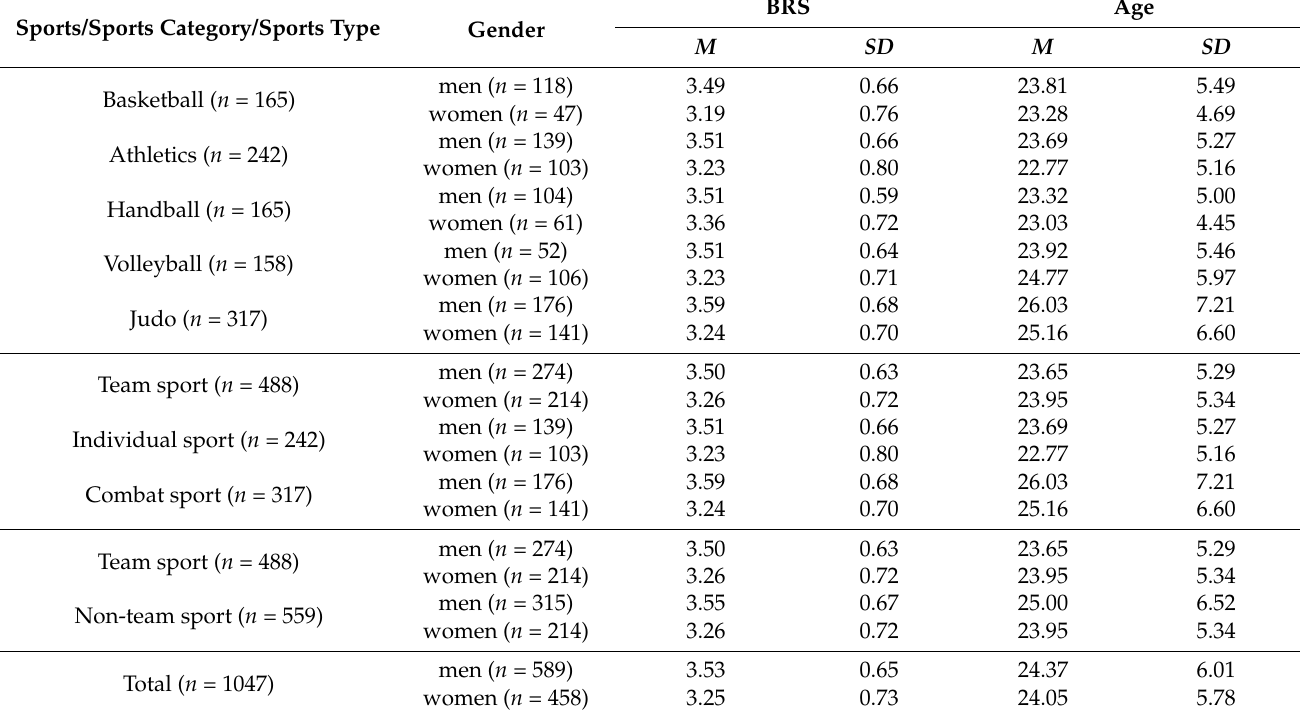
Table 1. Age and resilience descriptive data by gender, sport, sports category, and sport type. Sports/Sports Category/Sports